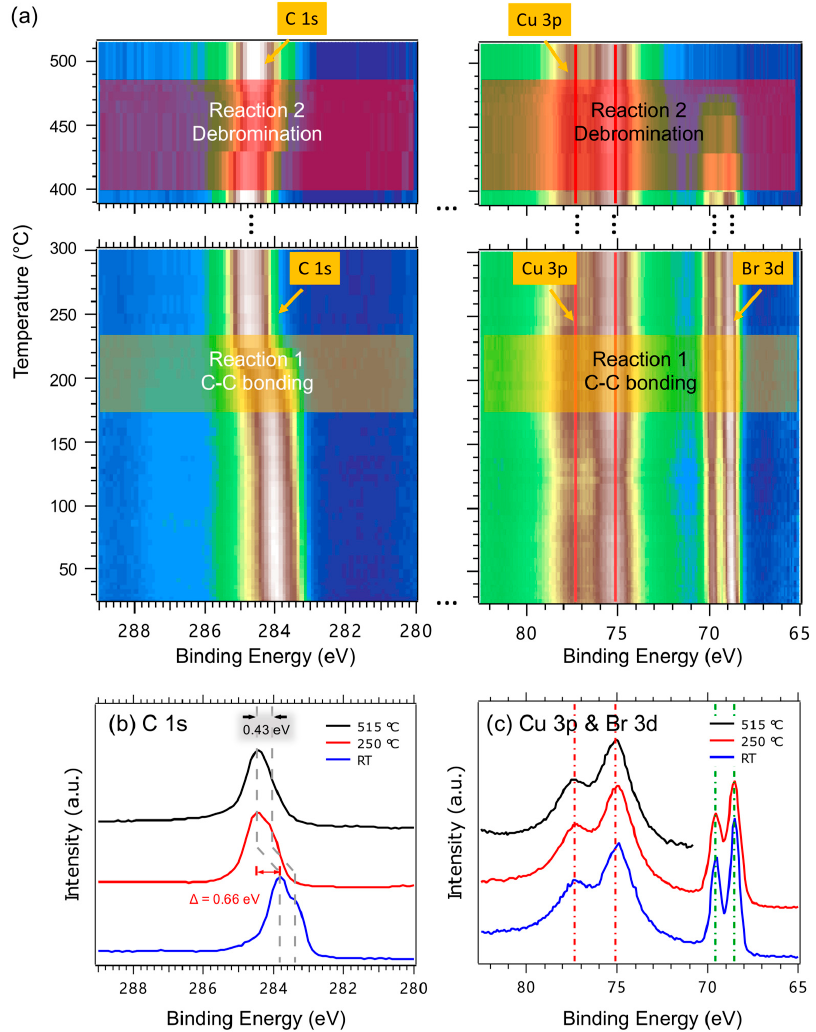
Figure 2. ( a ) Temperature-dependent C 1s, Cu 3p and Br 3d PES during the annealing process measured with photon energy of 400 eV. Two main reactions, C–C bonding (180–240 ◦ C) and debromination (400–480 ◦ C), are labelled. ( b , c ) High resolution C 1s, Cu 3p and Br 3d PES at room temperature (RT), 250 ◦ C and 515 ◦